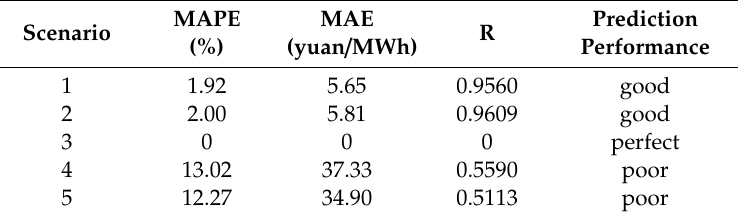
Table 6. The detailed information of di ff erent scenarios.